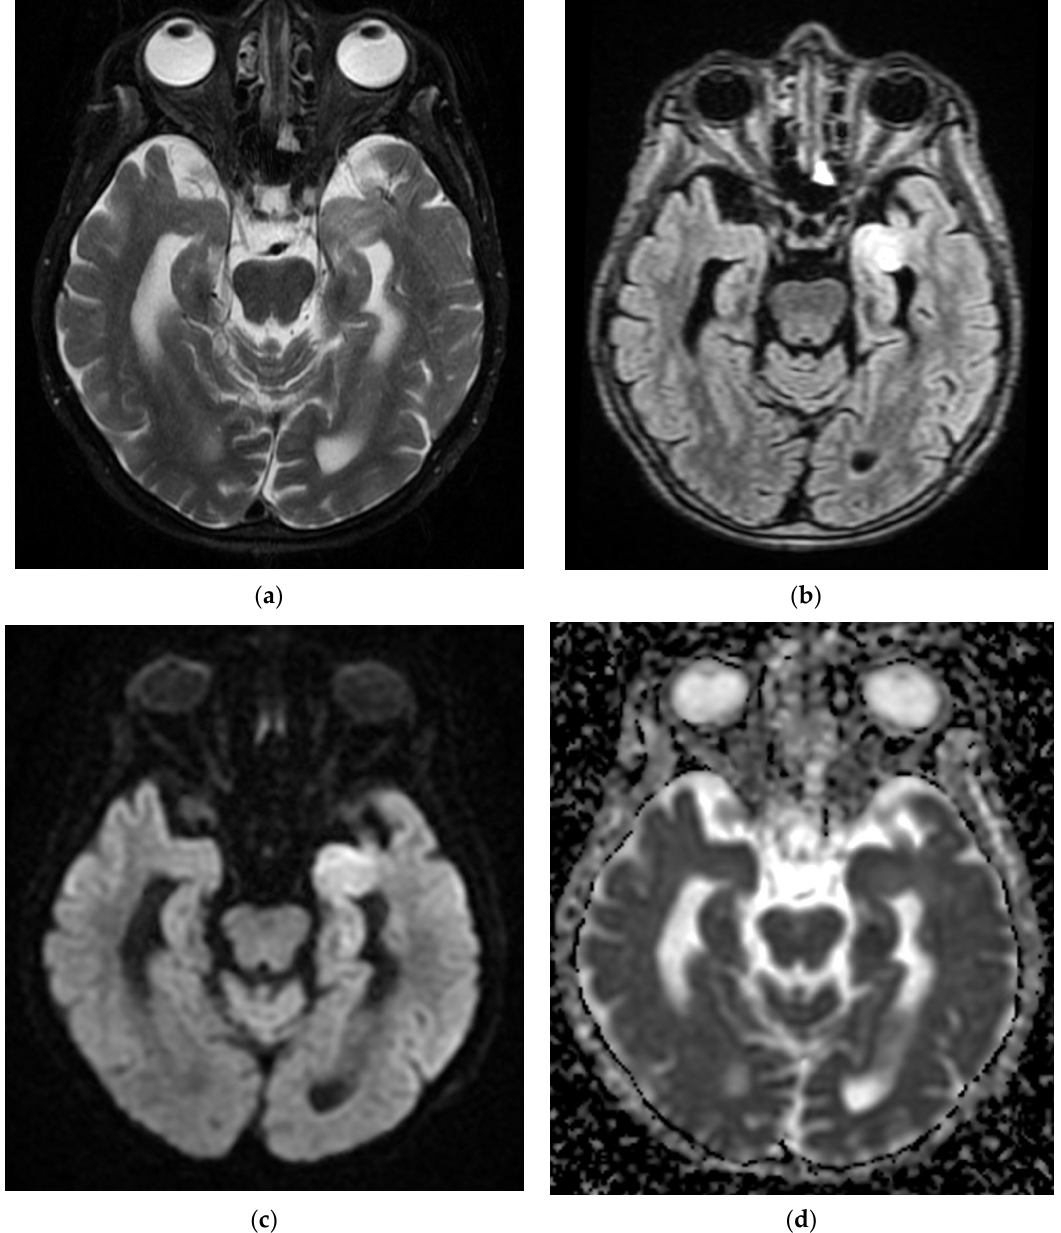
Figure 5. Cerebral MRI examination of the Case 5 patient highlights inaccurately delimited area of intense T2 and FLAIR signal ( a , b ), slightly restrictive in diffusion ( c , d ), situated in the cortical and subcortical area of the left tonsil. These images are conclusive for subacute tardive infarction on the territory of the anterior choroidal artery.